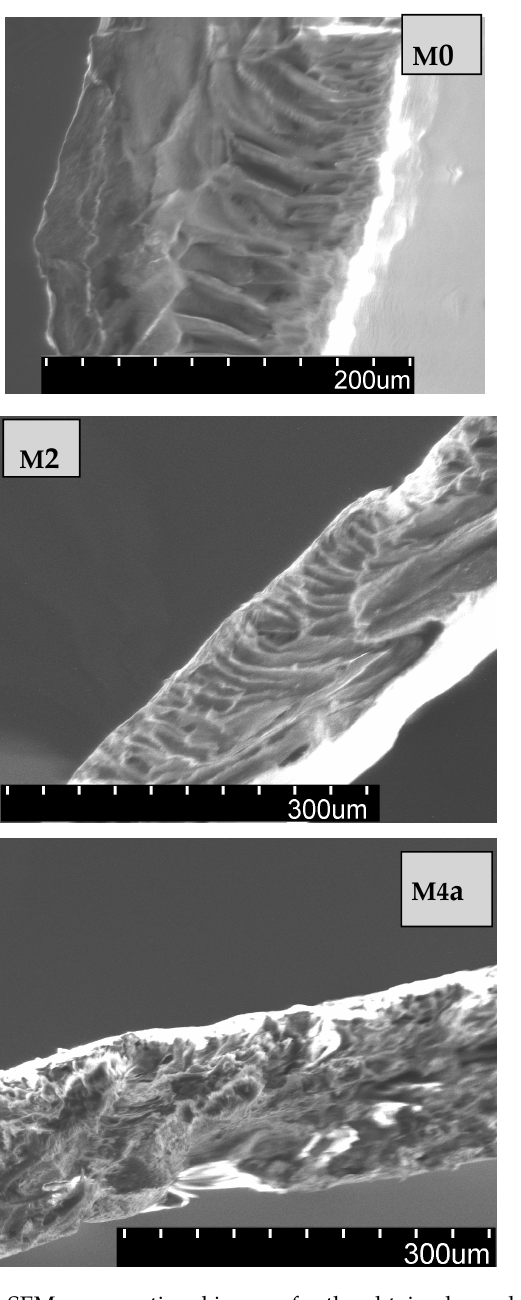
Figure 4. SEM cross-sectional images for the obtained membranes with different concentration of KIT-6 and KIT-6-NH 2 nanoparticles.